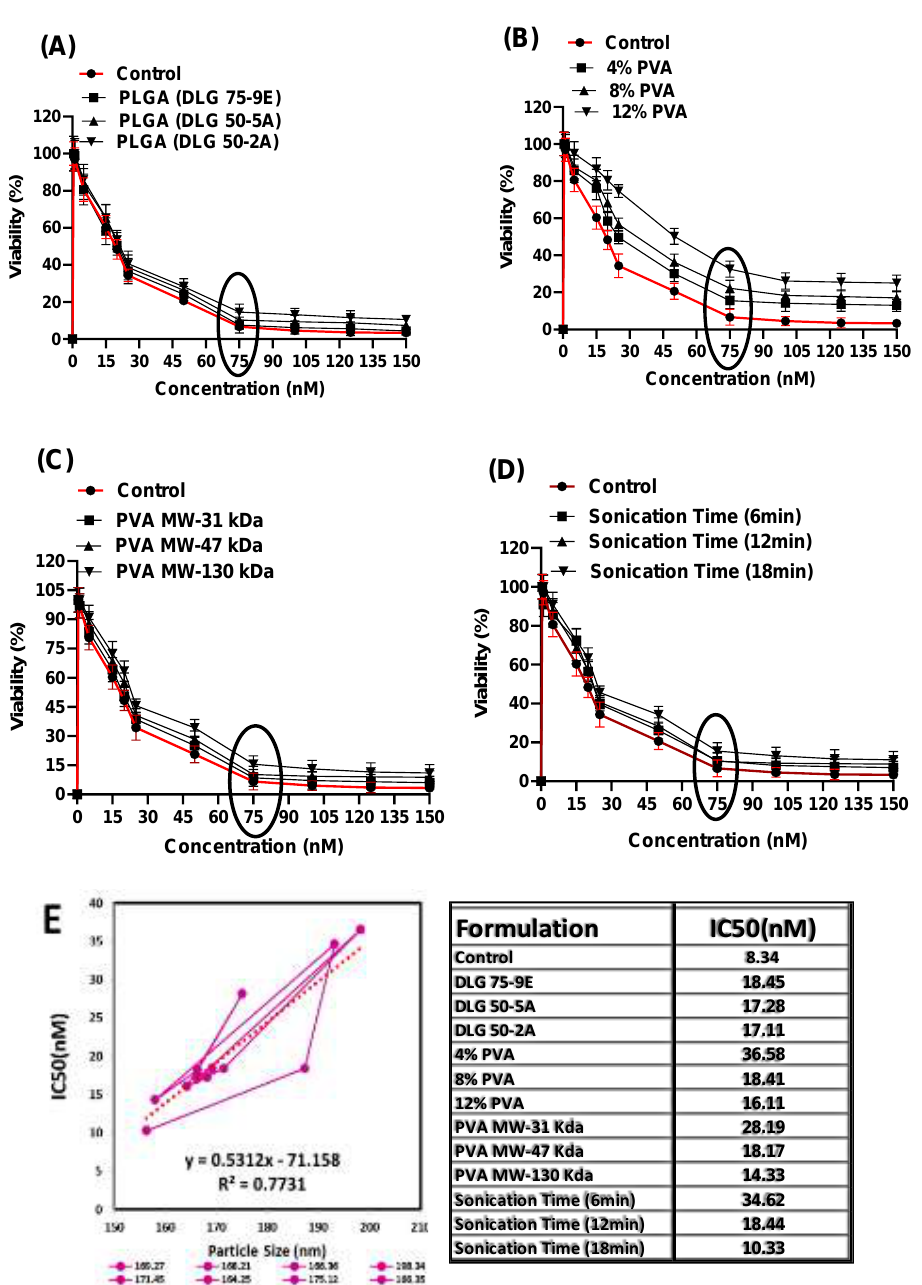
Figure 6. The influence of PLGA polymer (A), PVA loading (B), PVA molecular weight (C) sonication time (D) on the cytotoxicity of the 10% w/w 5-FU loaded nanoparticles with compared to native 5-FU controlled. The fundamental relationship between particle size and IC 50 value of the 10% w/w 5-FU loaded nanoparticles